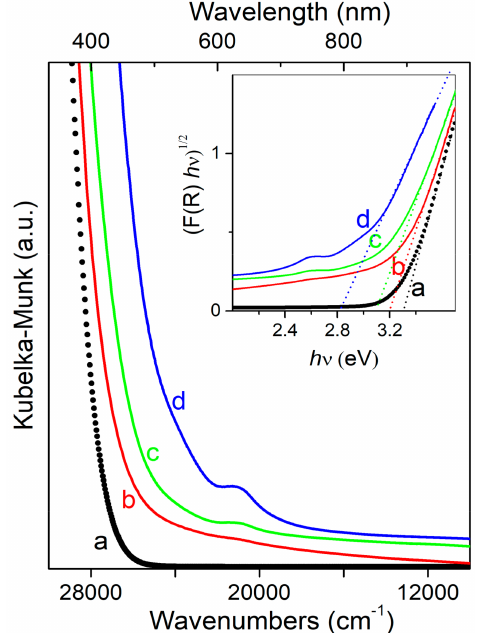
Figure 1. Diffuse reflectance UV–Vis spectra of: (a) hydrogen titanate nanotubes and the same nanotubes after ion exchange from Fe(NO 3 ) 3 solutions; (b) 0.001 M; (c) 0.0025 M and (d) 0.01 M. In the inset the relationship between (F(R) h ν ) 1/2 and the photon energy is